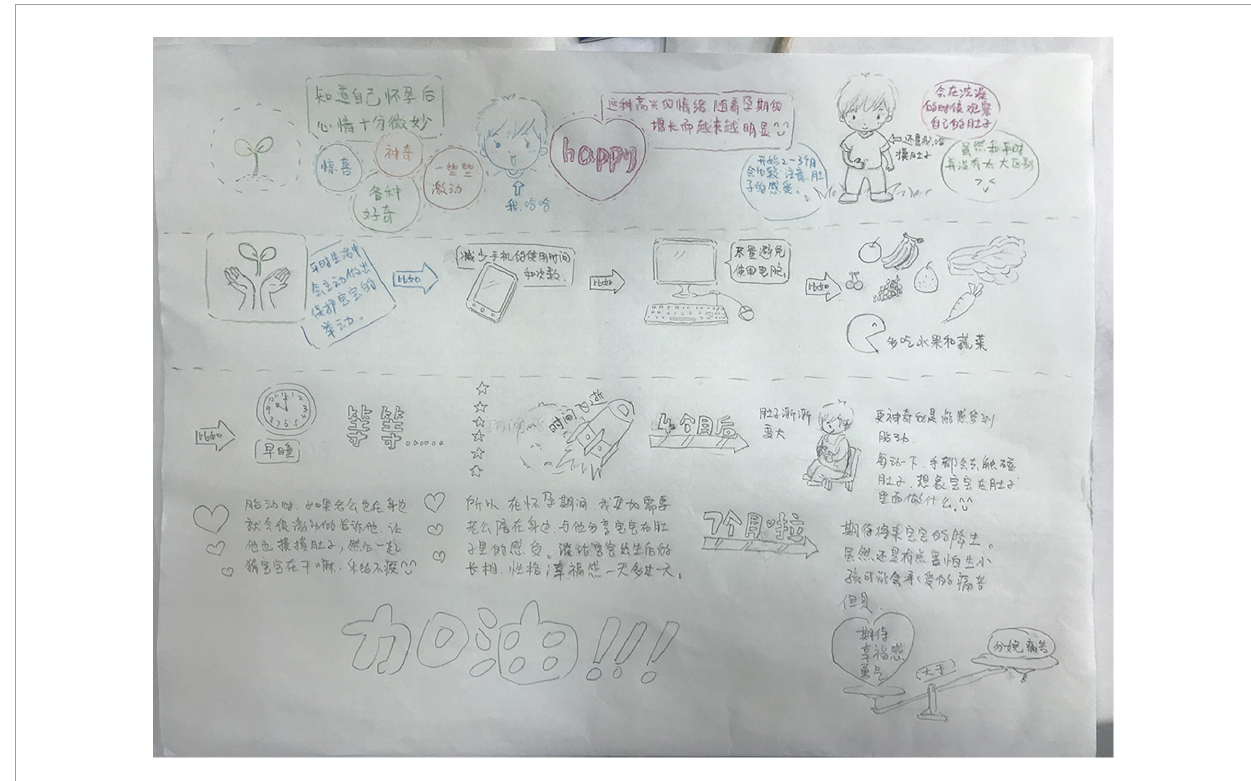
FIGURE1 A painting showing the whole pregnancy experience and emotional journey.